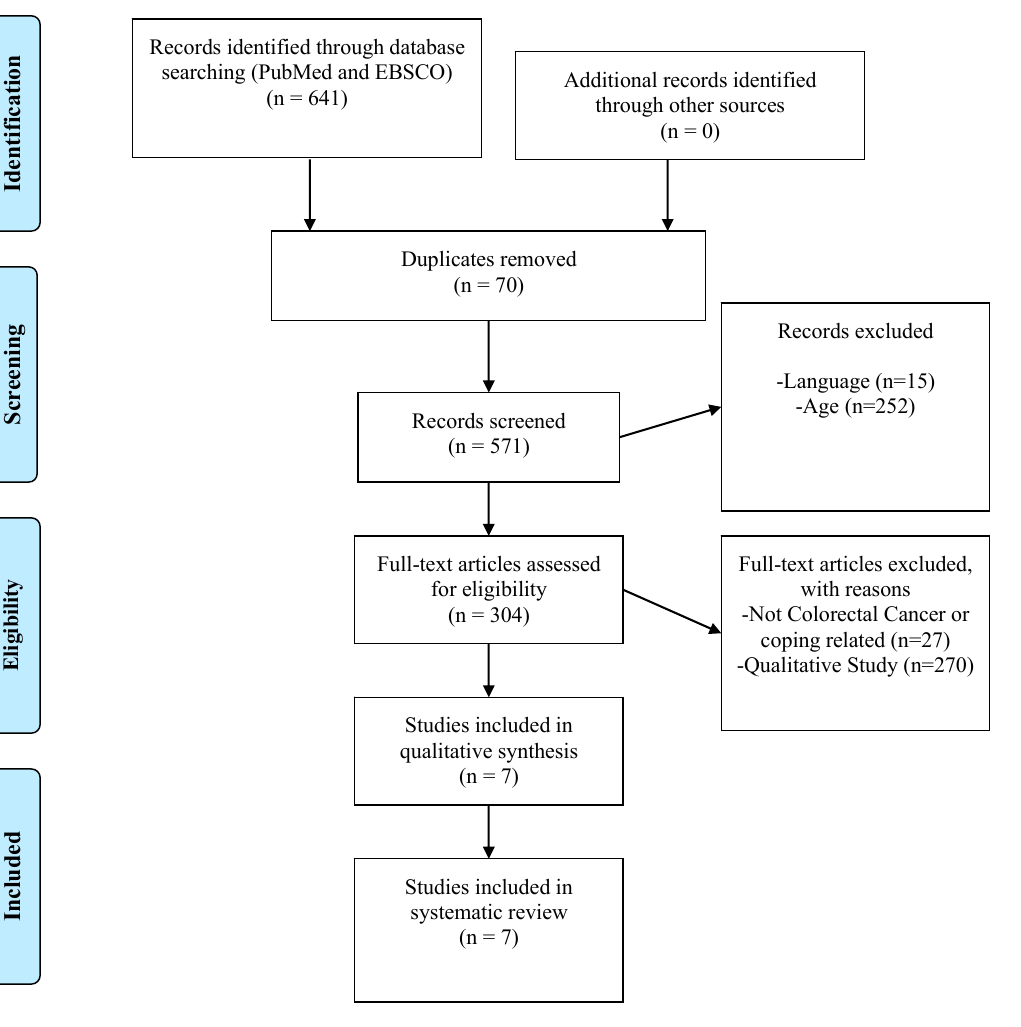
Figure 1. Flowchart of the selected studies.